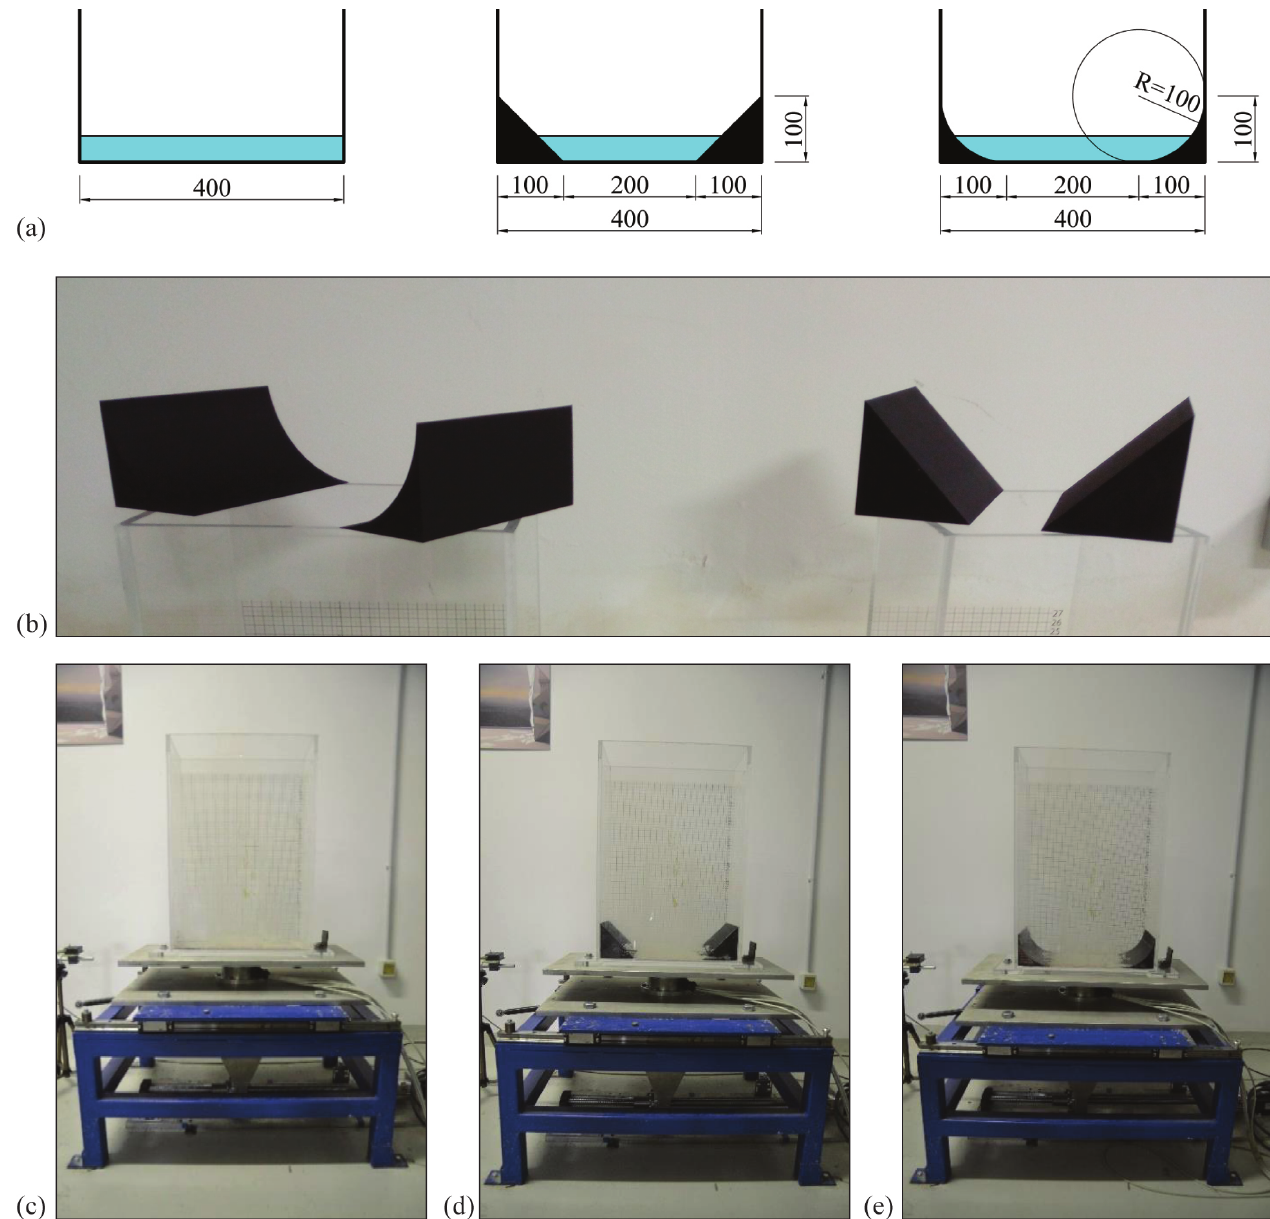
Figure 5. Experimental apparatus. ( a ) Scheme of the tanks dimensions (measurements in mm). ( b ) 3D printed blocks used to change the bottom shape. Images of the tanks with flat ( c ), sloped ( d ) and circular ( e ) bottom